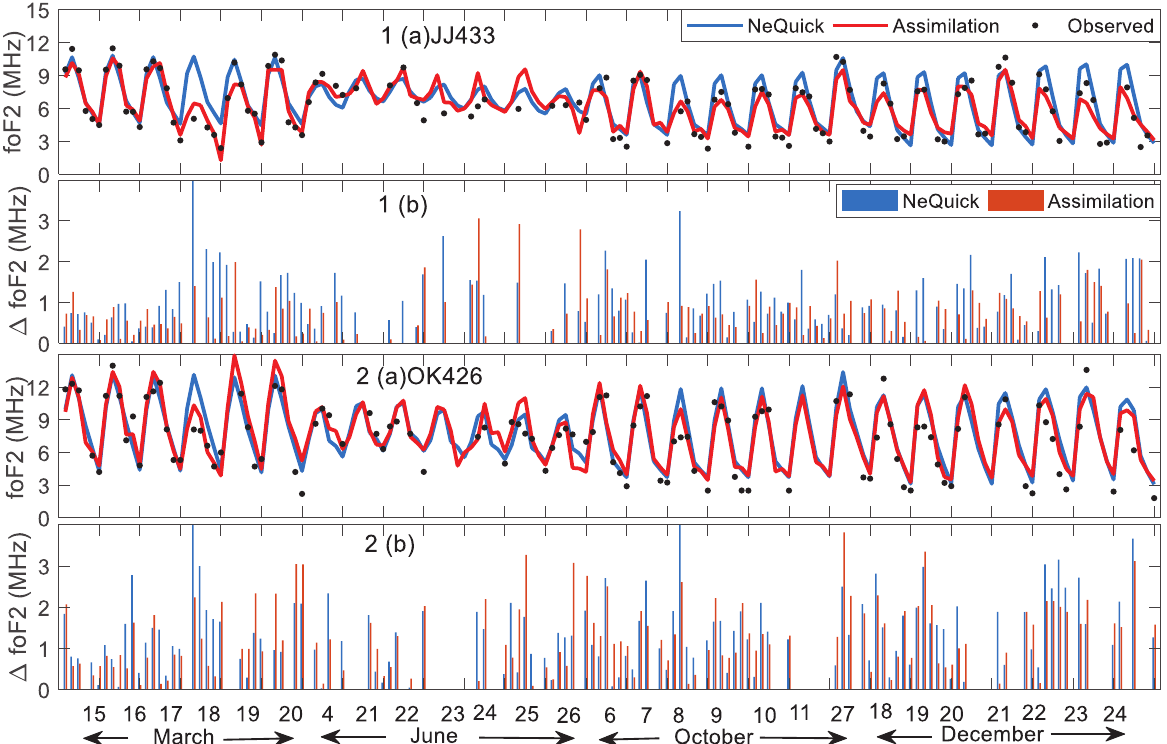
Figure 12. Panels 1 (a) and 2 (a) show foF2 obtained from NeQuick model (blue line), assimilation results (red line), and ionosonde stations (black dots) at JJ433 and OK426, respectively. Panels 1 (b) and 2 (b) present the magnitudes of the differences between foF2 obtained from NeQuick model (blue bars) and assismilation results (red bars) and that observed at ionosonde stations at JJ433 and OK426,